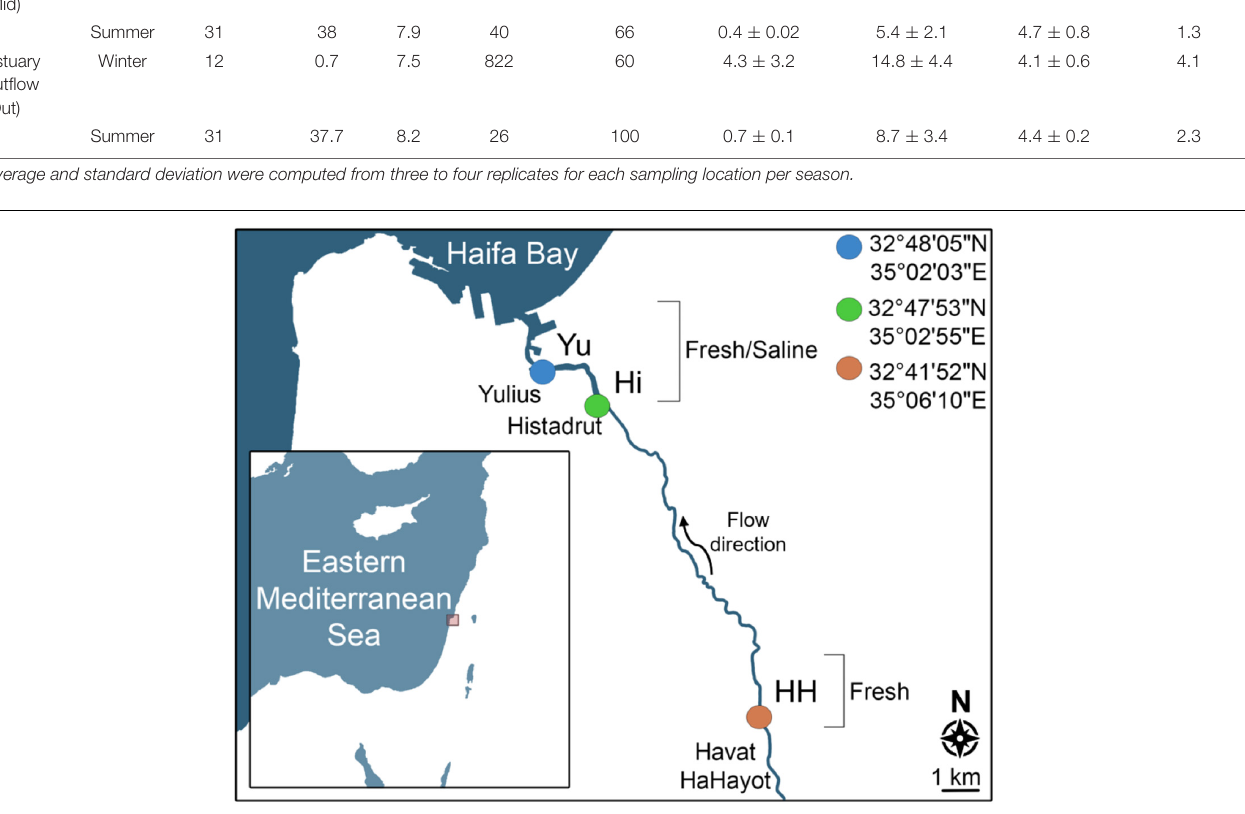
FIGURE 1 | Map of the sampling locations along the Qishon River: upstream (Up, orange), mid-estuary (Mid, green), and estuary outflow (Out, blue), during winter (February 2018) and summer (July